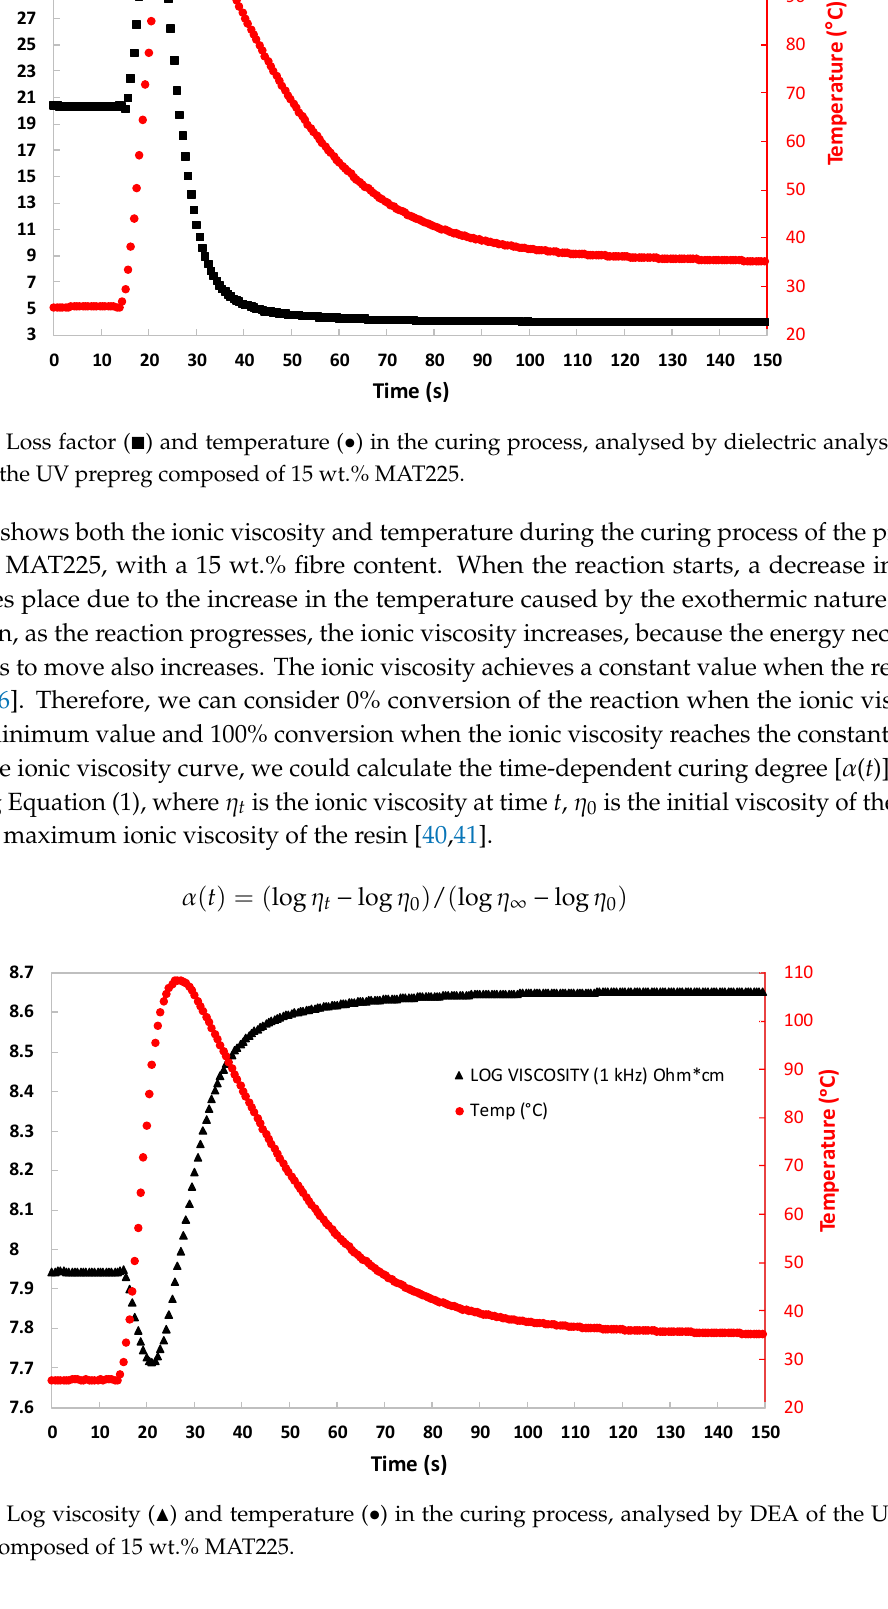
Figure 7. Log viscosity ( ▲ ) and temperature ( ● ) in the curing process, analysed by DEA of the UV prepreg composed of 15 wt.% MAT225.